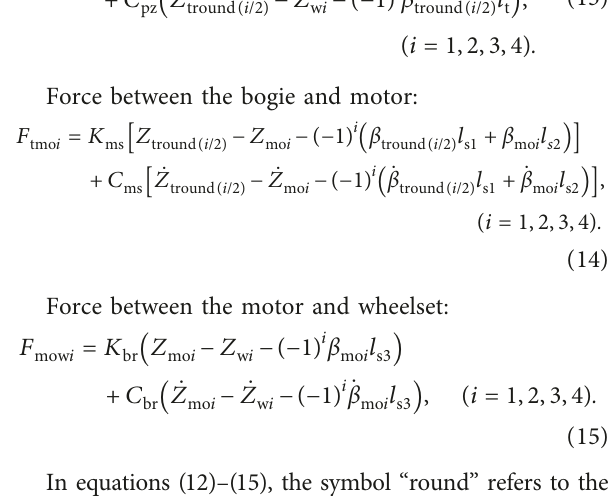
Table 1: Notation used in the locomotive subsystem. Notation